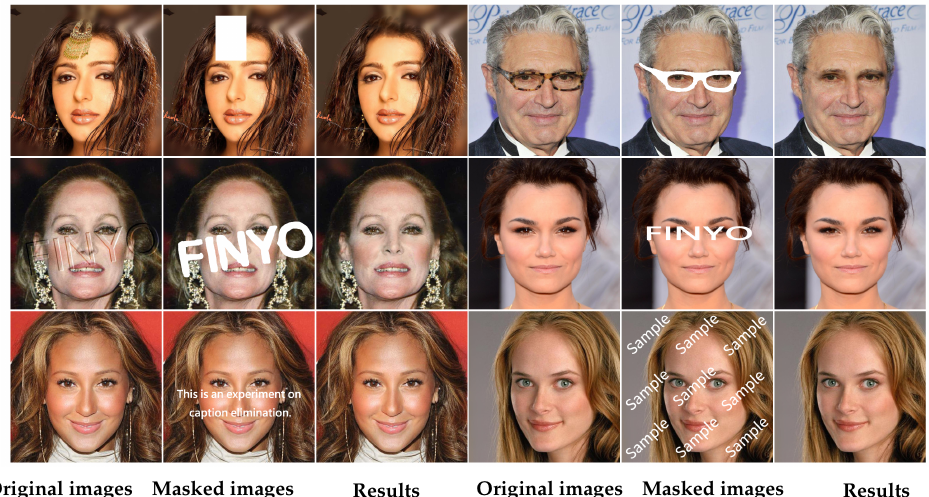
Figure 15. Different application experiments on face image inpainting. The experiments include watermark removal, text removal, and image editing.